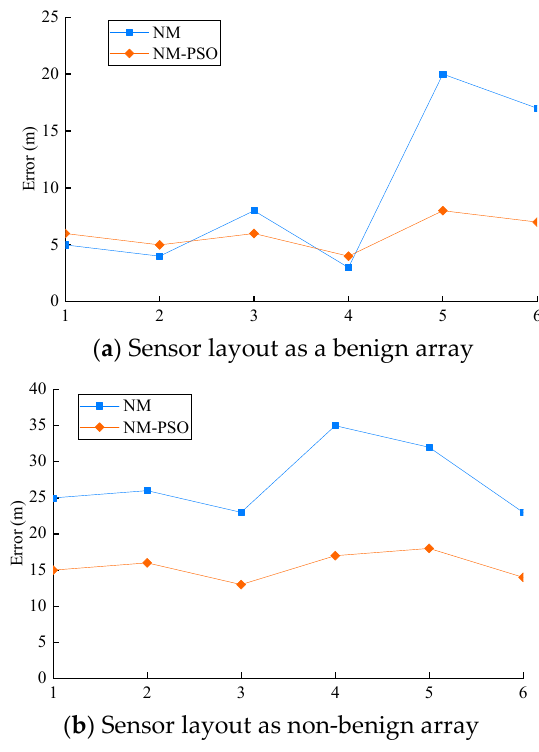
Figure 5. Comparison of positioning errors.